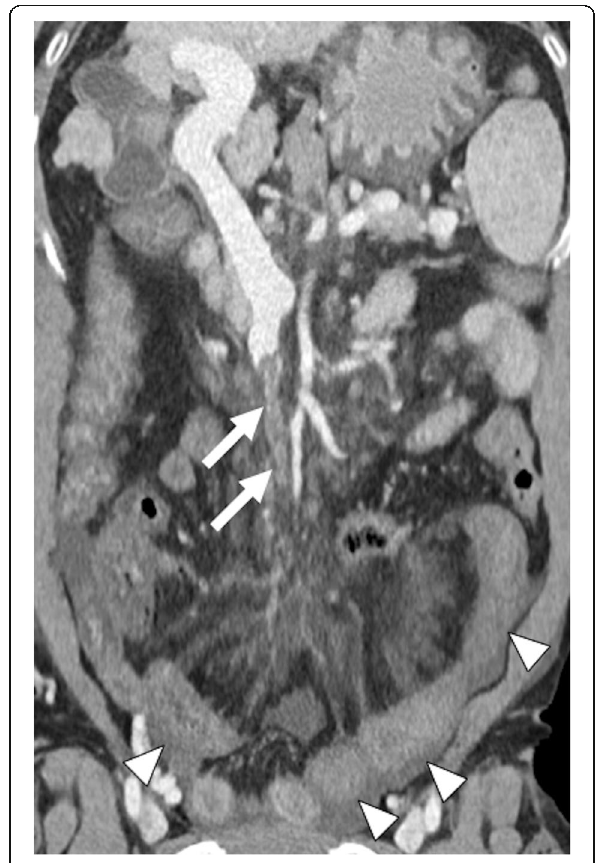
Fig. 5 SMV thrombosis. A 57-year-old female with known history of hepatitis B-related cirrhosis and Behcet ’ s disease presented to ED with severe abdominal pain and melena. Post-contrast curved MPR CT image shows thrombosed SMV (arrows) with associating severe mesenteric edema. Also, note is made of thickening of small bowel and colon segments (arrowheads) suggestive for venous bowel ischemia. Emergent surgery confirmed imaging findings and the patient underwent extensive bowel resection. The patient expired 3 days after the